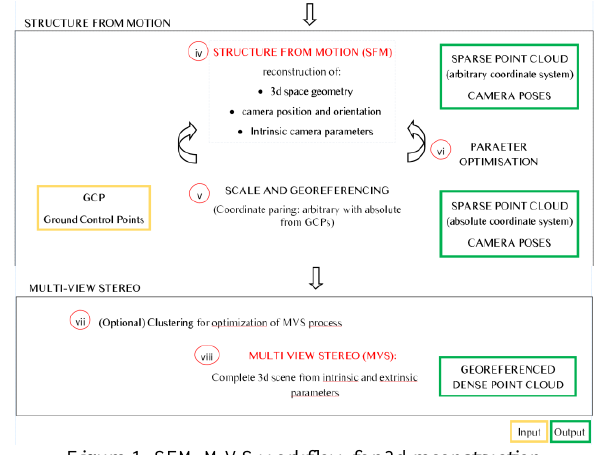
Figure 1. SFM MVS workflow for 3d